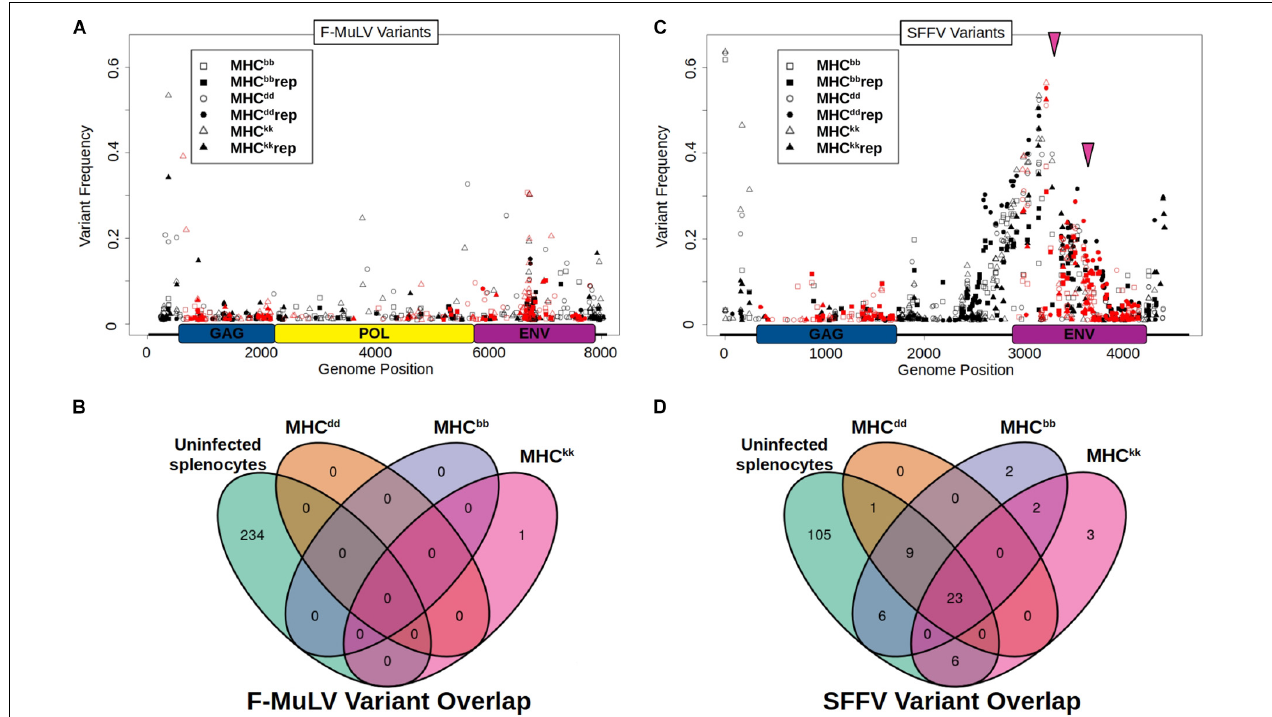
FIGURE 2 | F-MuLV and SFFV variants detected in post passage viral lines. (A,B) SNVs identified in (A) F-MuLV and (B) SFFV are shown. Host MHC genotypes are indicated by data point symbol. Independent biological replicates are denoted by filled or open symbols. Non-coding or synonymous mutations are shown in black while non-synonymous mutations are shown in red. Pink Arrows indicate genomic positions of common, in-frame insertions of post passage virus populations. Genomic maps of viral open reading frames are shown on the x axis of plots. GAG, group antigens; POL, polymerase and ENV, envelope. (C,D) Overlap between high frequency ( > 10%) variants from (C) F-MuLV and (D) SFFV populations and ERVs from uninfected mouse RNA-seq are shown using Venn-diagrams. SNVs detected in both replicates of each MHC host genotype are compared to identify MHC specific variants and those shared between different host MHC types. MHC genotype of passage is shown next to ovals. Variants detected in RNA seq of uninfected BALB/c splenocytes are shown in green oval. Variants below a population frequency of 10% are not shown.